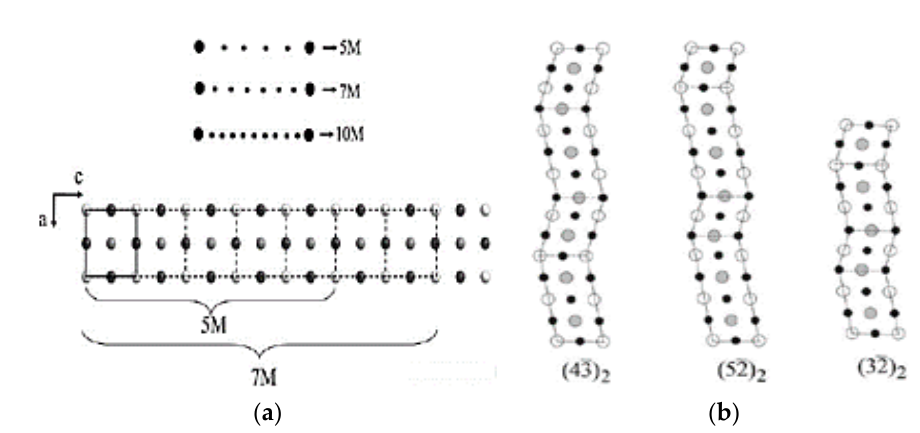
Figure 2. ( a ) Graphical representation of the nM = s + 1 relationship; ( b ) three examples of Zhdanov sequences of martensitic layered surfaces—7 M and 5 M modulations [35], with copyright permission from © Trans Tech.